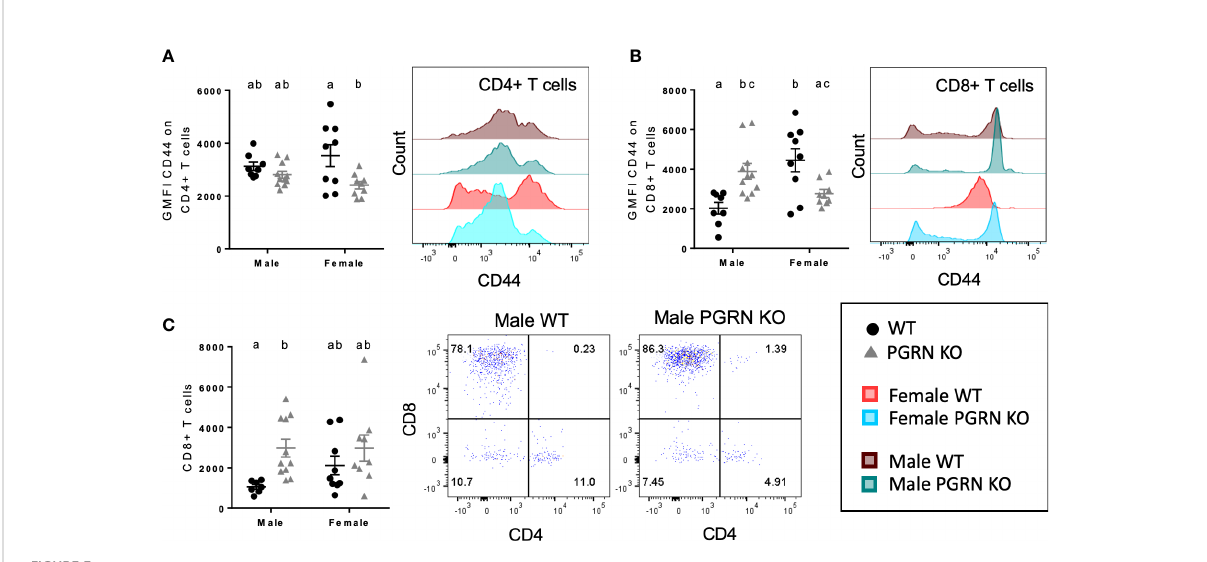
FIGURE 3 PGRN de fi cient mice have altered T cell populations in the peripheral blood and brain. GMFI of CD44 on (A) CD4 + and (B) CD8 + T cells in peripheral blood, and (C) CD8 + T cell counts in the brain from aged WT and PGRN KO mice (n=8-10) determined by fl ow cytometry; two-way ANOVA, genotype effect p < 0.01 for (A , C) , interaction p < 0.0001 for (B) , Tukey ’ s post hoc . Histograms show distribution of fl uorescence intensity per cell. Letter(s) centered above groups re fl ect results of post hoc tests. Groups that do not share any letters are signi fi cantly different from one